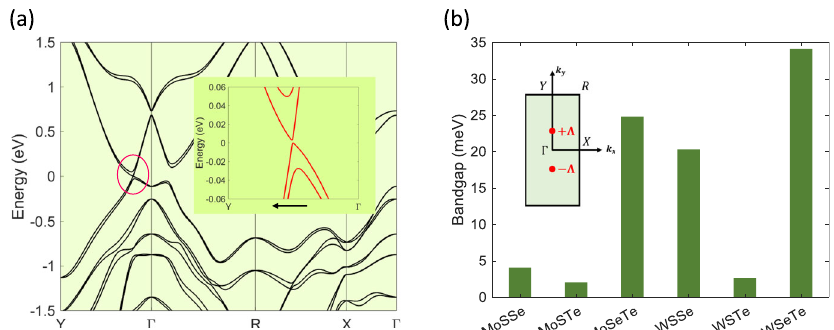
Fig. 3 Electronic band structure of 1T ′ JTMDs. a Band structure of 1T ′ MoSSe, the energy offset is moved to the top of the valence band. Inset: band structure around the fundamental bandgap Λ (along Γ – Y ). It is clear that the strong Rashba splitting breaks the twofold degeneracy. b Fundamental bandgaps of all six MXY. Inset: fi rst Brillouin zone of 1T ′